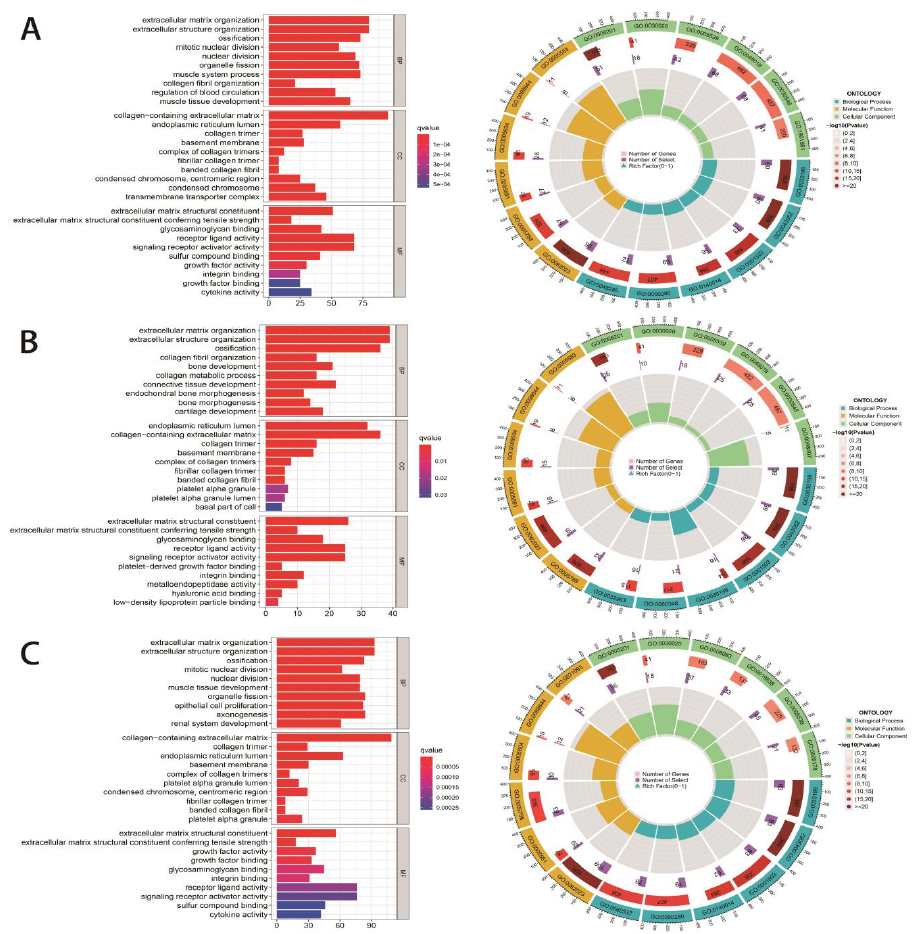
Figure 4. Gene ontology analysis in different sexes. ( A ) Gene ontology analysis of the non-specific DEGs. ( B ) Gene ontology analysis of the male-specific DEGs. ( C ) Gene ontology analysis of the fe- male-specific DEGs.